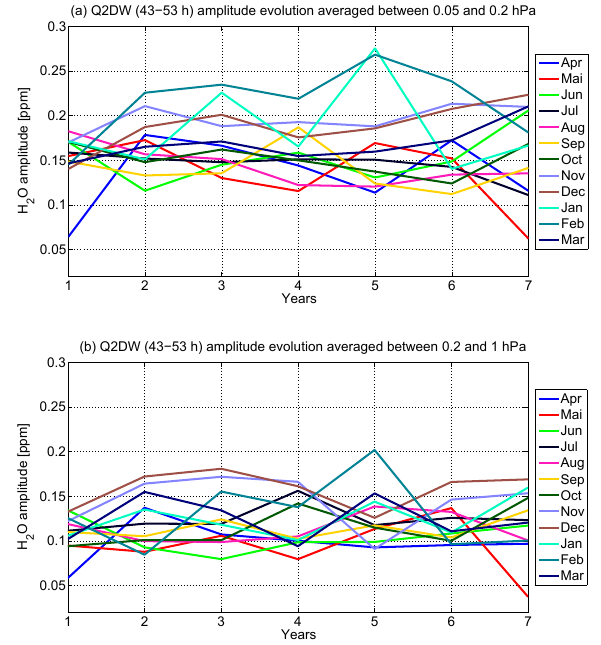
Figure 8. Monthly breakdown of Q2DW (43–53h) amplitude de- velopment over the 7 investigated years. The H 2 O pressure-layer- averaged amplitudes are 0 . 05–0 . 2hPa (a) and 0 . 2–1hPa (b) . The years range depending on the month from either 2010 to 2016 (Oc- tober to December) or from 2011 to 2017 (January to